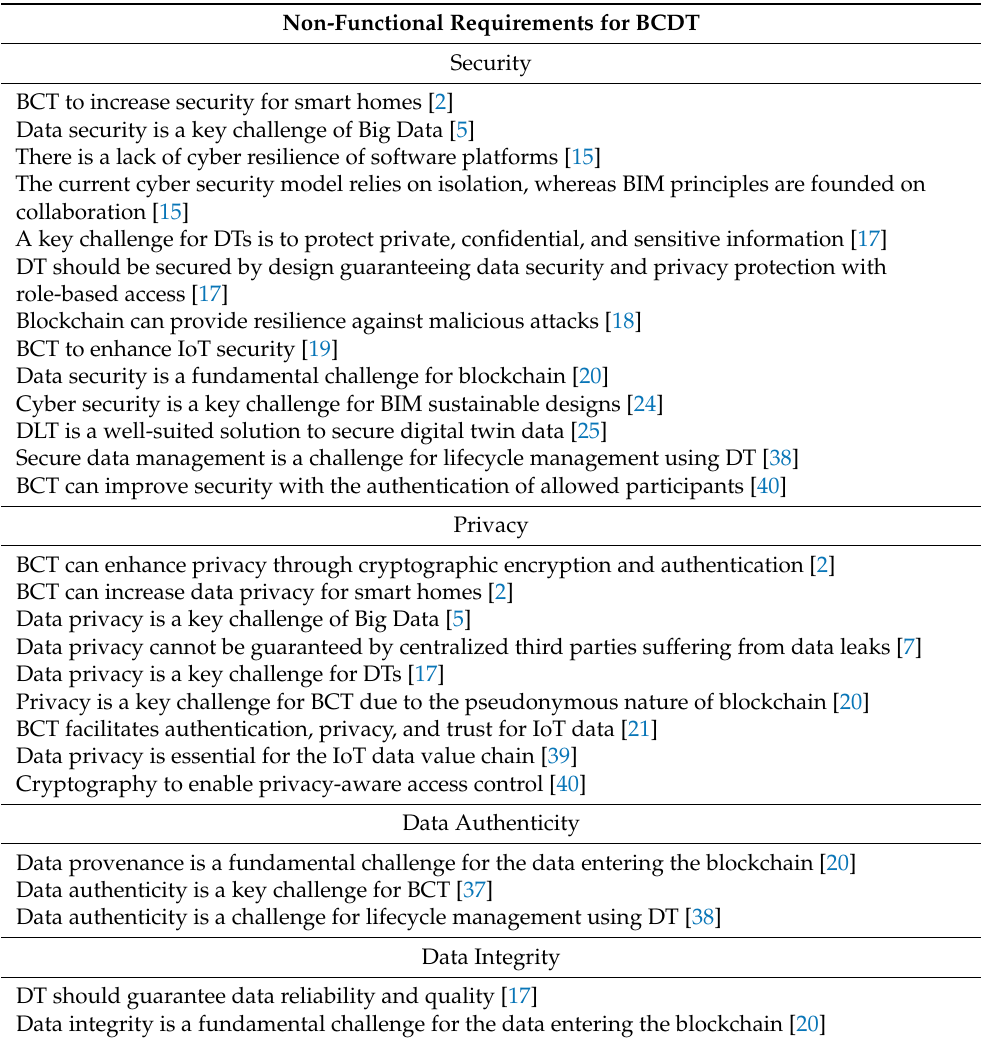
Table 3. Non-functional requirements for